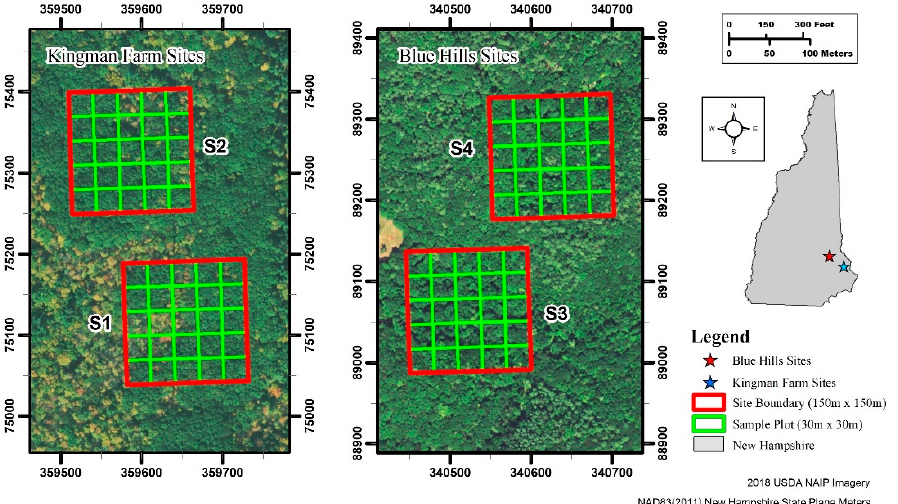
Figure 1. Map of study sites and relative location within New Hampshire. The label next to each site is a unique identifier for that site. Site boundaries are 150 m × 150 m. Two sites were established in the University of New Hampshire Kingman Farm Research Forest in Madbury, NH, USA (see Sites S1 and S2) and other two in the Blue Hills Foundation conservation lands in Strafford, NH, USA (see Sites S3 and S4). Sample plots within each site are 30 m × 30 m. Ground data were collected at the center of each sample plot.